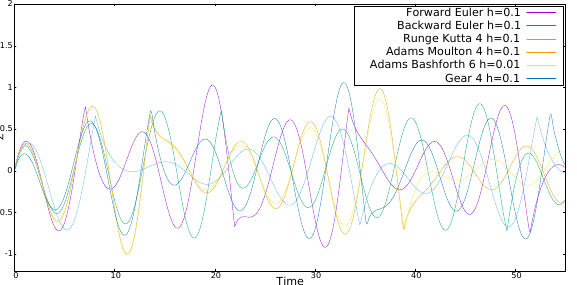
Figure 1. Time series of x of CO2 given in Table 1 with initial conditions x 0 = y 0 = z 0 = 0.01.